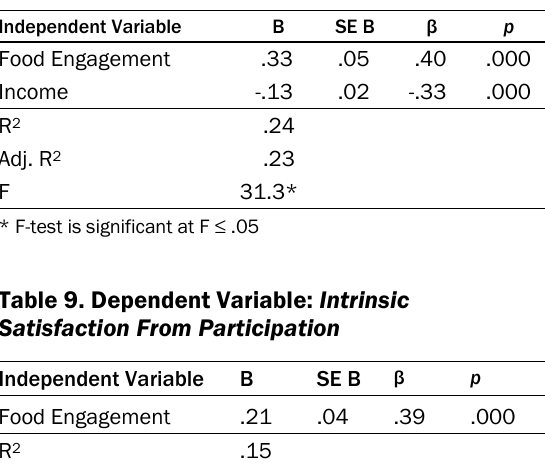
Table 8. Dependent Variable: Intrinsic